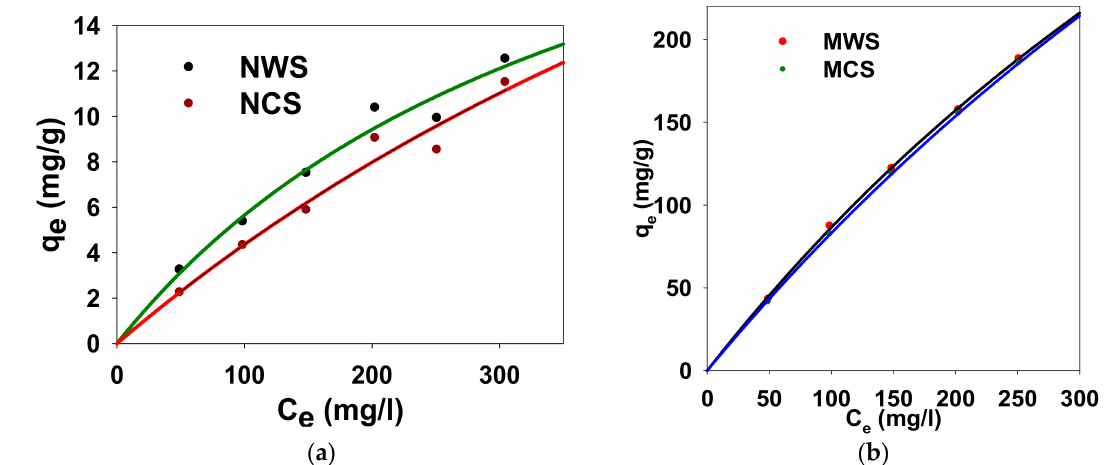
Figure 6. Effect of initial Pb (II) concentration on the adsorption capacity of ( a ) NCS and NWS ( b ) MCS and MWS (initial concentration 50, 100, 150, 200, 250, 300 mg/L, pH 4.4, speed 150 rpm, time 2 h, temp 22 ◦ C, adsorbent dose 1